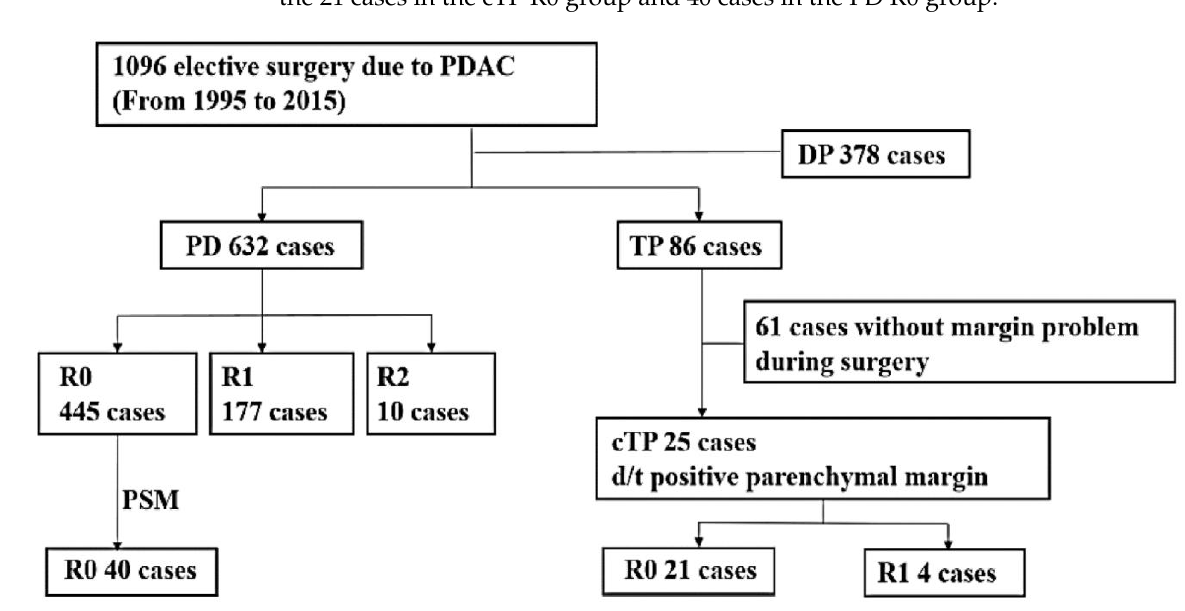
Figure 1. Inclusion and exclusion flows in our study. Abbreviations: PDAC, pancreatic ductal adenocarcinoma; PD, pancreaticoduodenectomy; TP, total pancreatectomy; DP, distal pancreatectomy; cTP, completion total pancreatectomy; d/t, due to; PSM, propensity score matching.